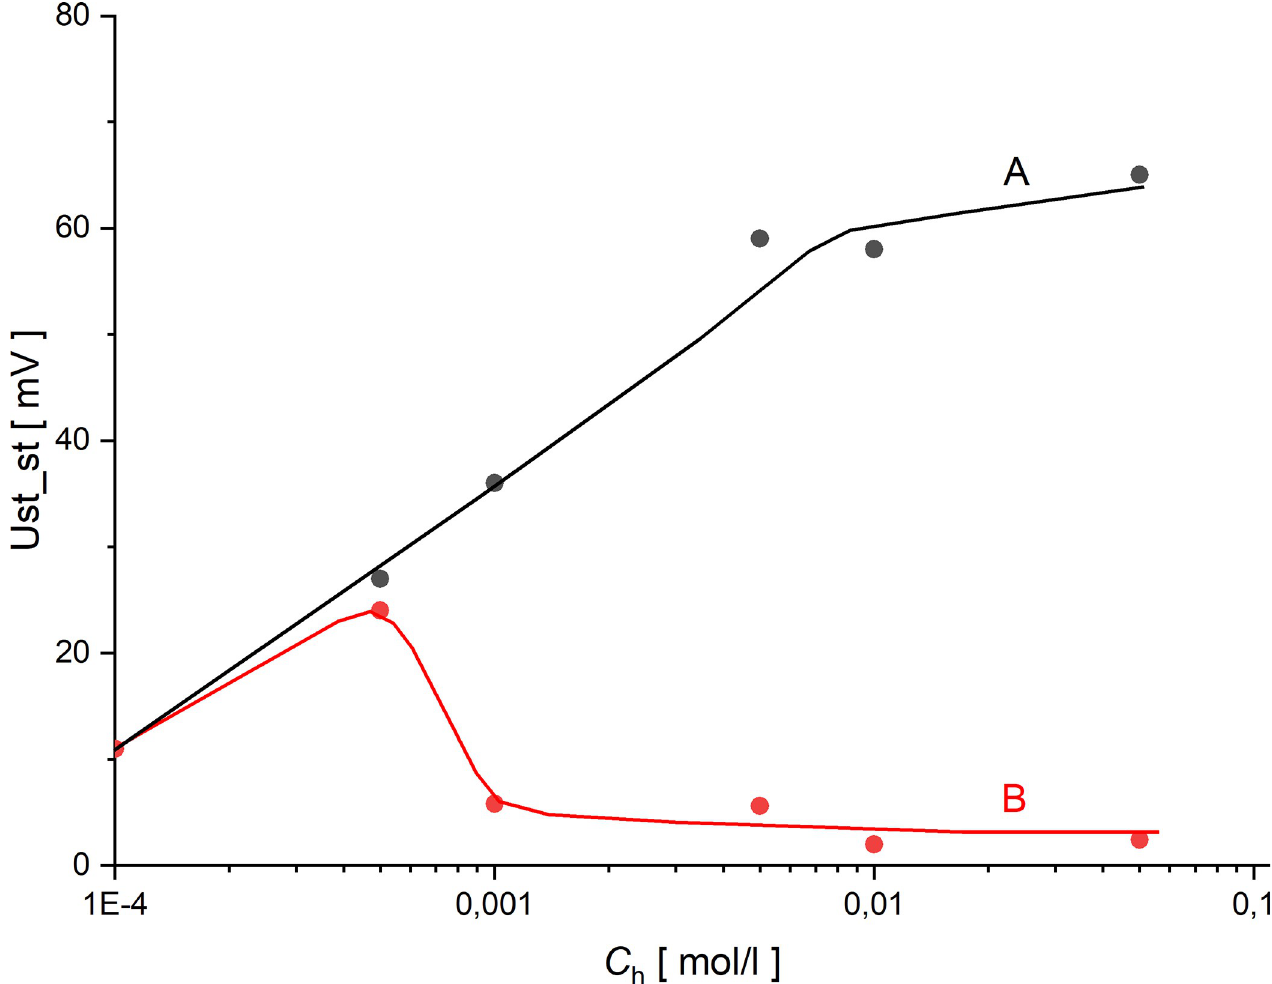
Fig 6. Voltage in the steady state of the membrane system as a function of higher concentration for configurations A (black) and B (red).